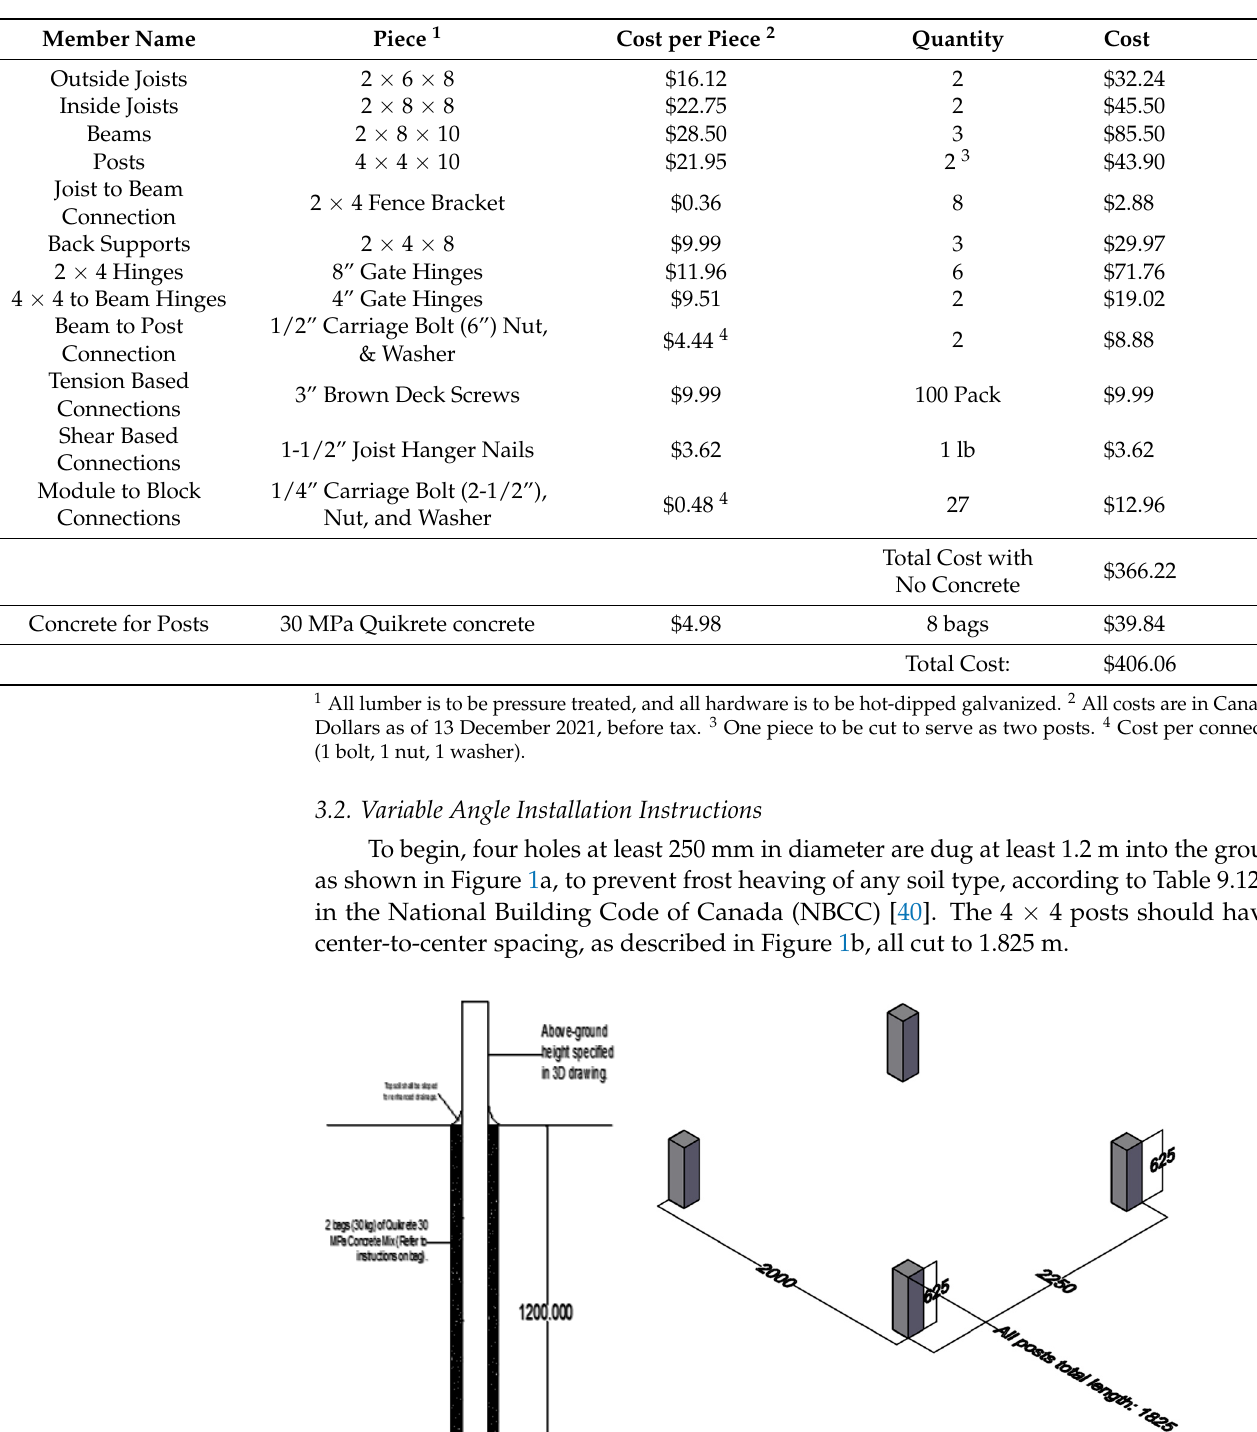
Table 2. Variable angle rack list of materials.